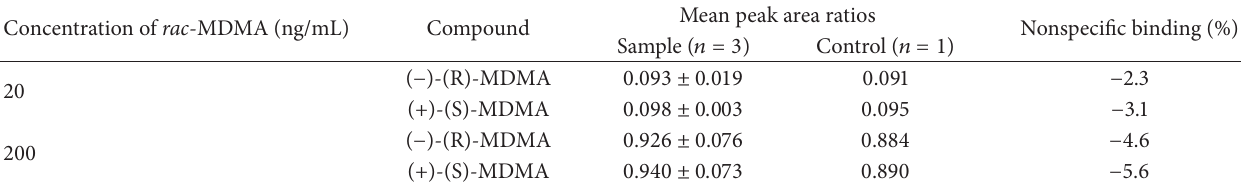
Table 1: Percentage of nonspecific binding of rac -MDMA to ultrafiltration